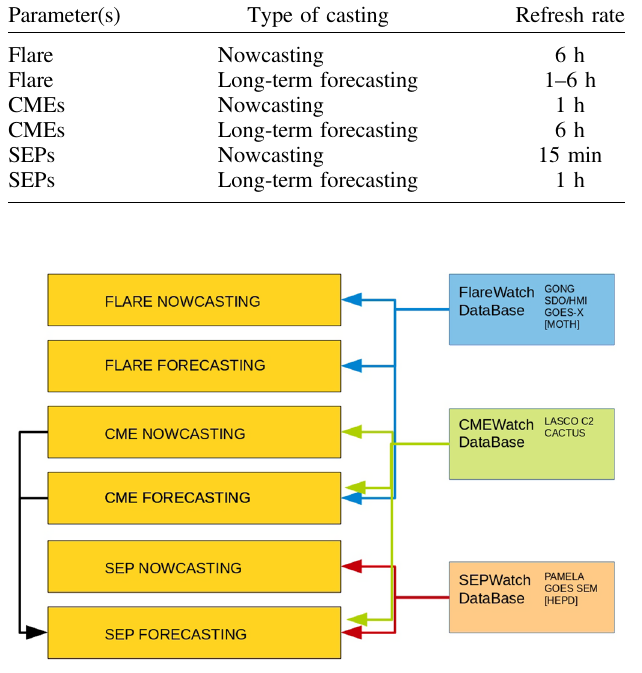
Fig. 1. Block diagram summarizing the developed RPF 1 products and their input data.